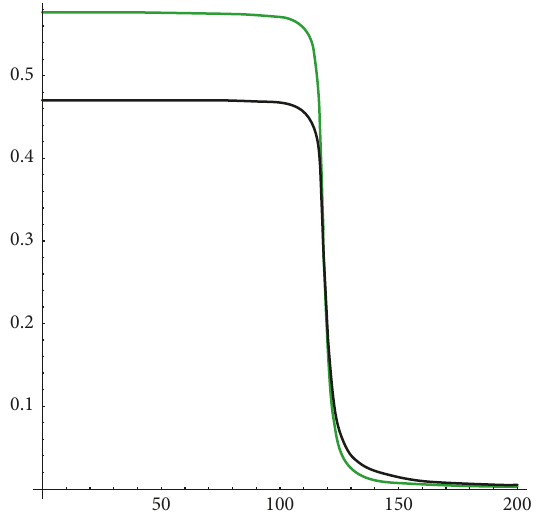
Figure 12: Plot of 𝐻(𝑡)/√𝑀 0 (black) and 𝐻 𝑐 (𝑡)/√𝑀 0 (green) for the yellow trajectory in the potential Φ + . For better clarity, we truncated the plot at 𝑡 = 200 s.